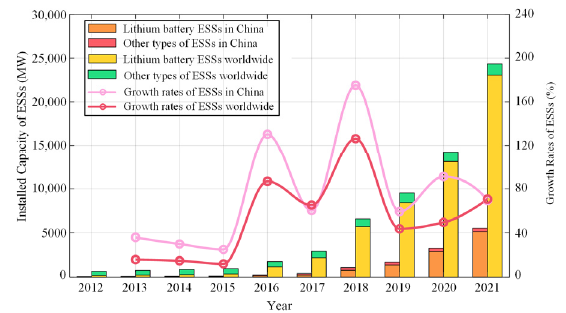
Figure 10. Installed capacity and growth rate of ESSs.